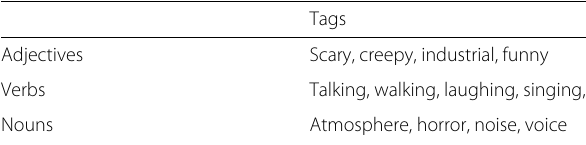
Table 3 High-frequency tags common across